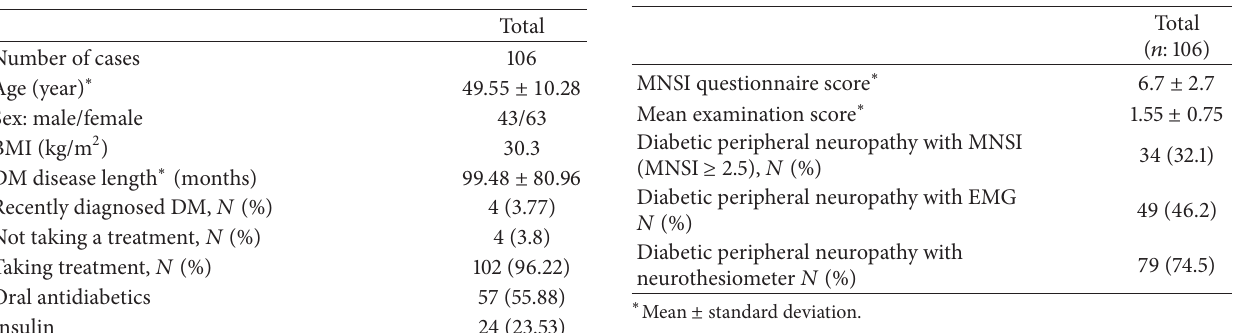
Table 1: General characteristics of the study group. Table 2: Results of MNSI, EMG, and